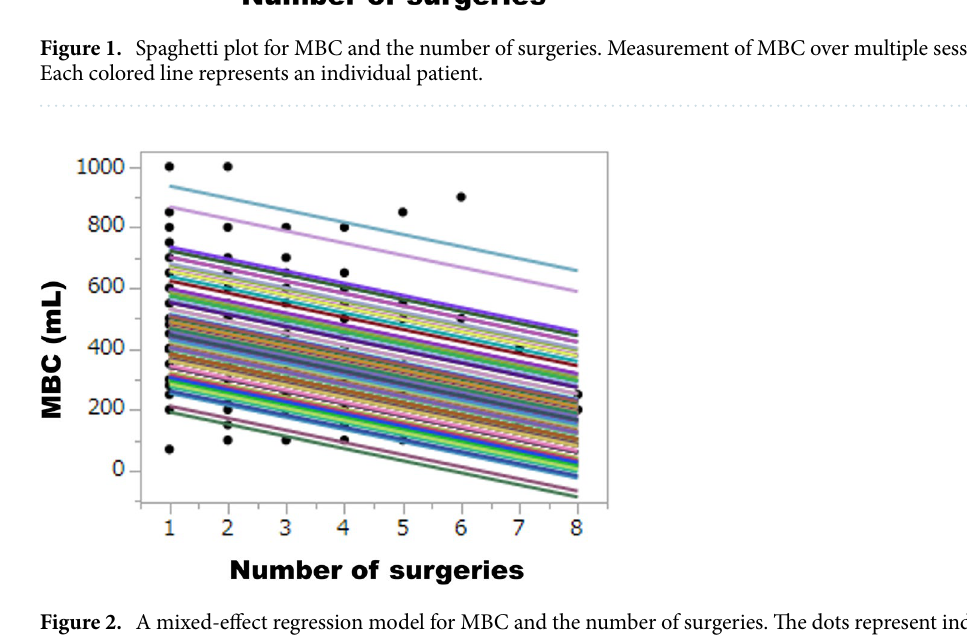
Figure 2. A mixed-effect regression model for MBC and the number of surgeries. The dots represent individual MBC measurements over time. Each colored line depicts the fitted regression line for an individual patient, with a fixed slope and random